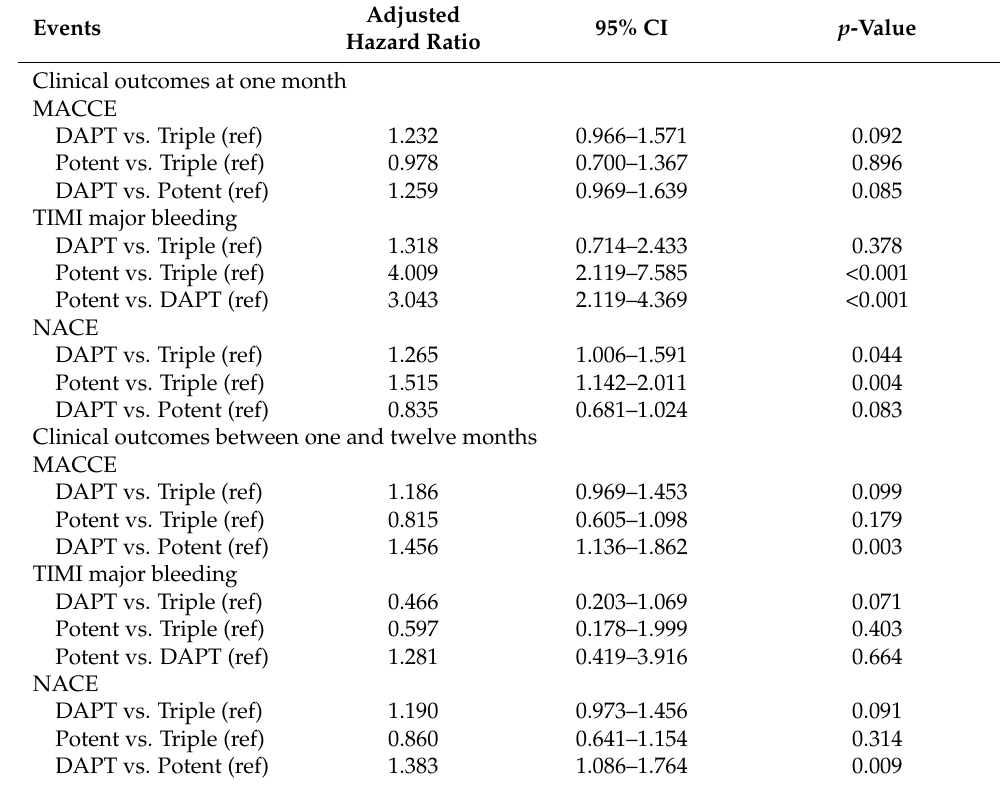
Table 3. Independent risk for clinical events by multivariate Cox hazard regression